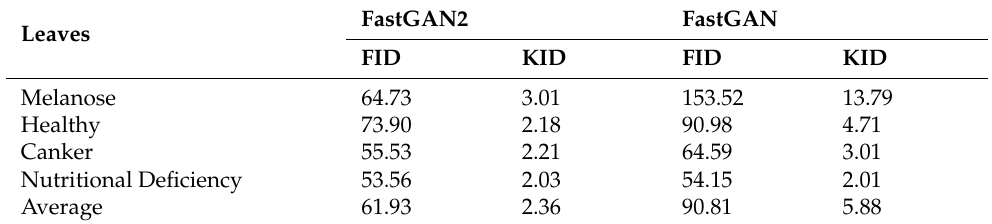
Table 2. Comparison of FID and KID scores of FastGAN2 and FastGAN on four kinds of leaves.